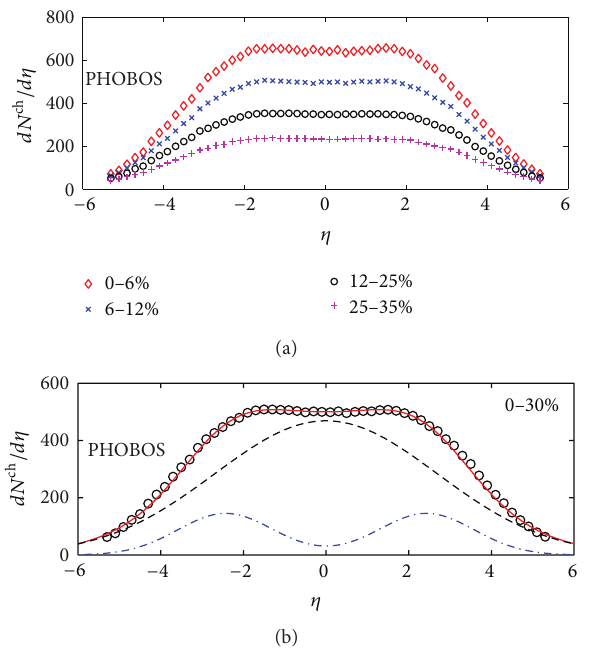
Figure 1: Pseudorapidity distribution in Au-Au collisions at √𝑠 𝑁𝑁 = 200 GeV for (a) various centrality bins and (b) 0–30% centrality. Data are from [12]. The (red) line in (b) is a fit using (2), whose first term is represented by the dashed line and the other two terms by the dash-dotted line (color online).